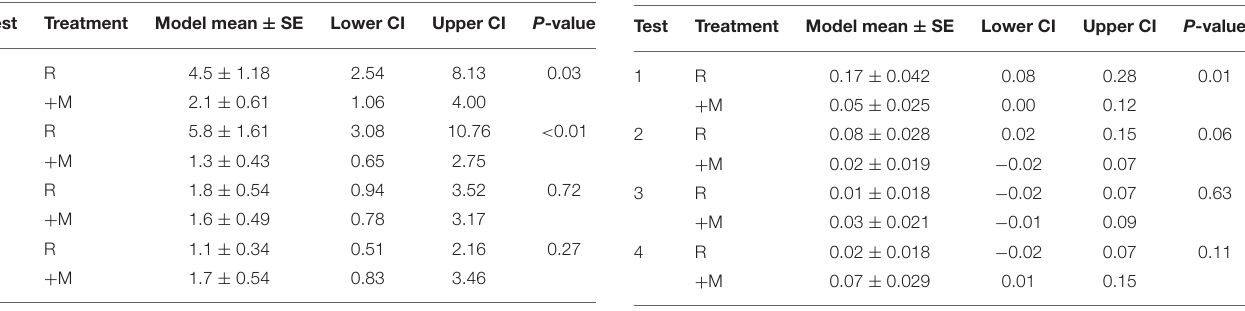
TABLE 6 | The model means of the proportion of EP to AT (EP:AT) between Treatment by Test ± standard error of mean (SE), upper and lower confidence intervals (CI), and P- value of cows within Treatment across